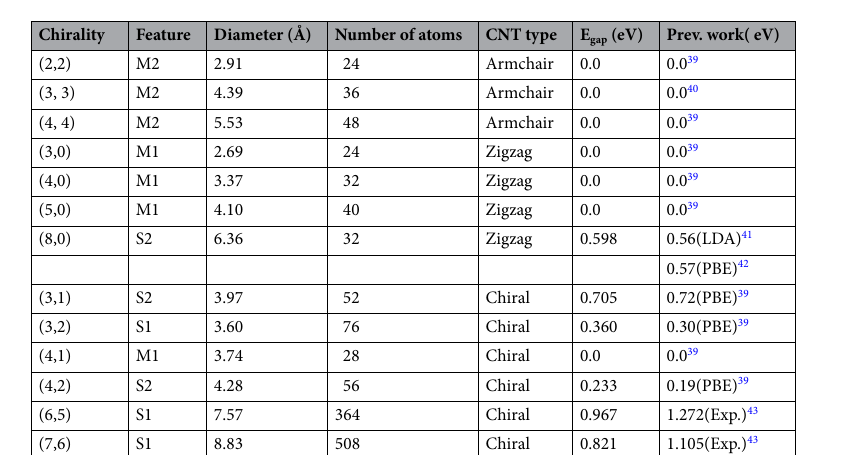
Figure 2. Top: cutting lines in zone folding illustration of armchair and zigzag CNTs. Bottom: the corresponding DFT electronic band structures. Valence and conduction bands are represented in red and blue colours, respectively. Fermi energy E F is set to zero.